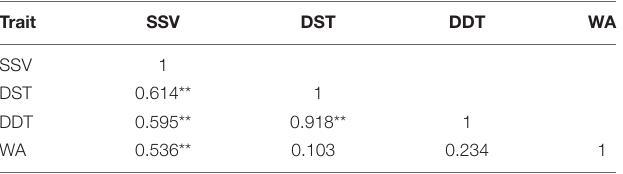
TABLE 2 | Pearson’s correlation analysis among SDS-sedimentation volume (SSV), dough stability time (DST), dough developing time (DDT), and water absorption (WA) in E5/2018–2019 (Beijing).